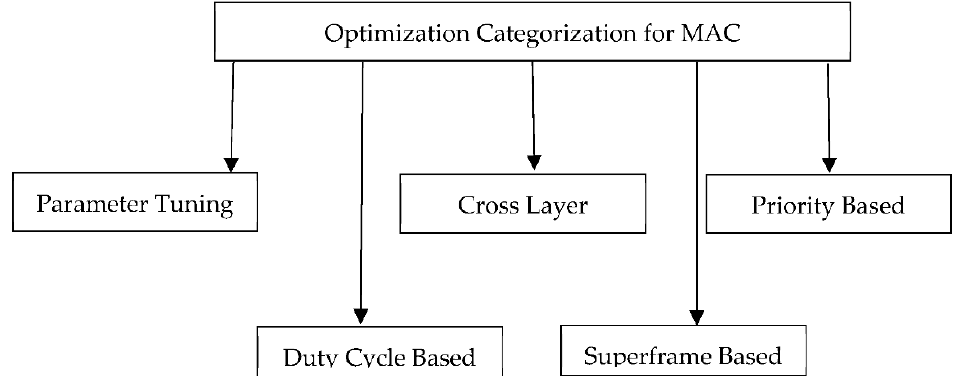
Figure 7. Optimisation approach categorisation for IEEE 802.15.4 and IEEE 802.15.6.